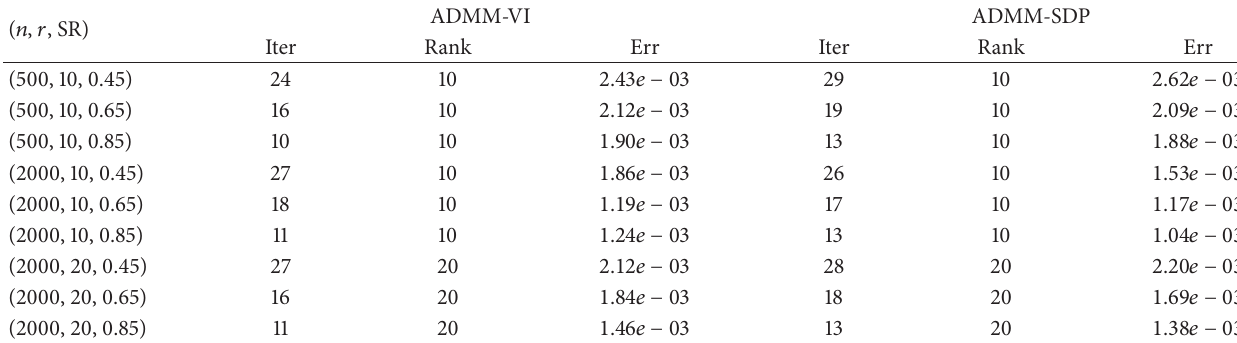
Table 2: Numerical results on medium randomly created matrix completion